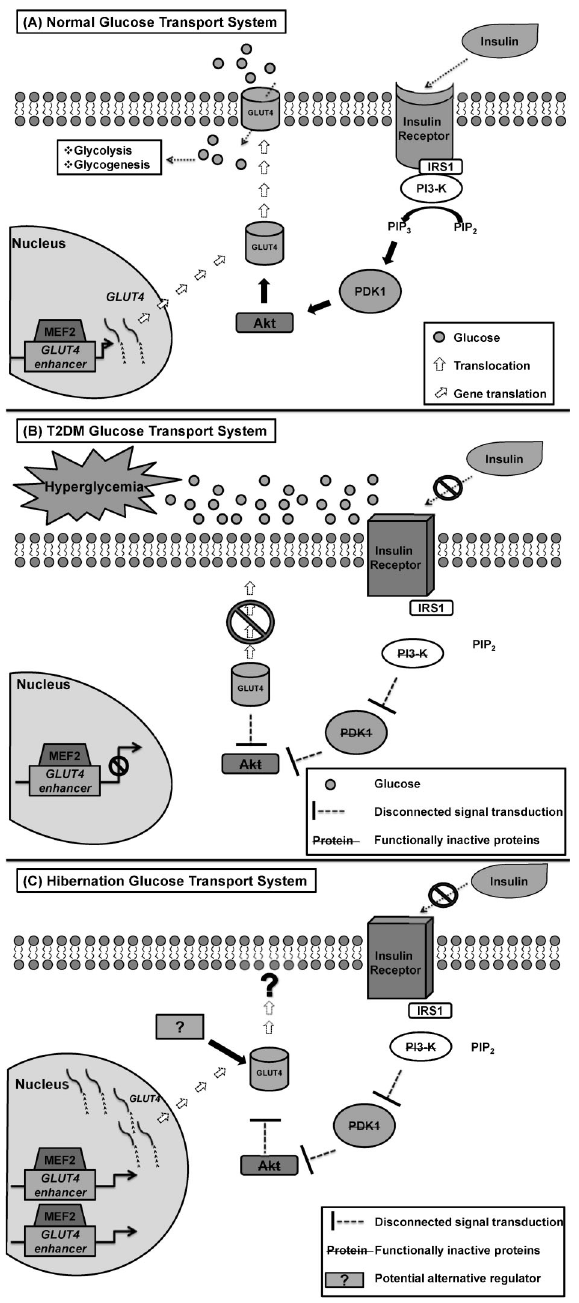
Figure 1. Insulin-signaling pathway. Interactions between insulin molecules and the insulin receptor initiate a signal transduction cascade via the activation of PI3-K. The downstream cascade stimulates the activation of Akt, which facilitates the translocation of GLUT-4 transporter towards the plasma membrane, where active glucose transport takes place. The transcription factor MEF-2 interacts with the GLUT4 enhancer regions to promote the transcription of GLUT4 , and upregulate GLUT-4 expression. A , Functional glucose transport system, where transported glucose is either stored via glycogenesis, or broken down via glycolysis. B , T2DM glucose transport system, where insulin resistance inhibits the activation of PI3-K, and disrupts the signal transduc- tion pathway that facilitates the translocation of GLUT-4 transporter. Accumulation of glucose molecules leads to the onset of hyperglycemia. C , Hibernation glucose transport system. Reversible suppression of carbohydrate-based metabolism dur- ing hibernation results in the deliberate downregulation of the Akt signal transduction pathway. However, enhanced MEF-2 activity coupled with upregulated GLUT4 expression during late hiberna- tion suggests the possibility of alternative metabolic pathways that regulate the GLUT-4 transport